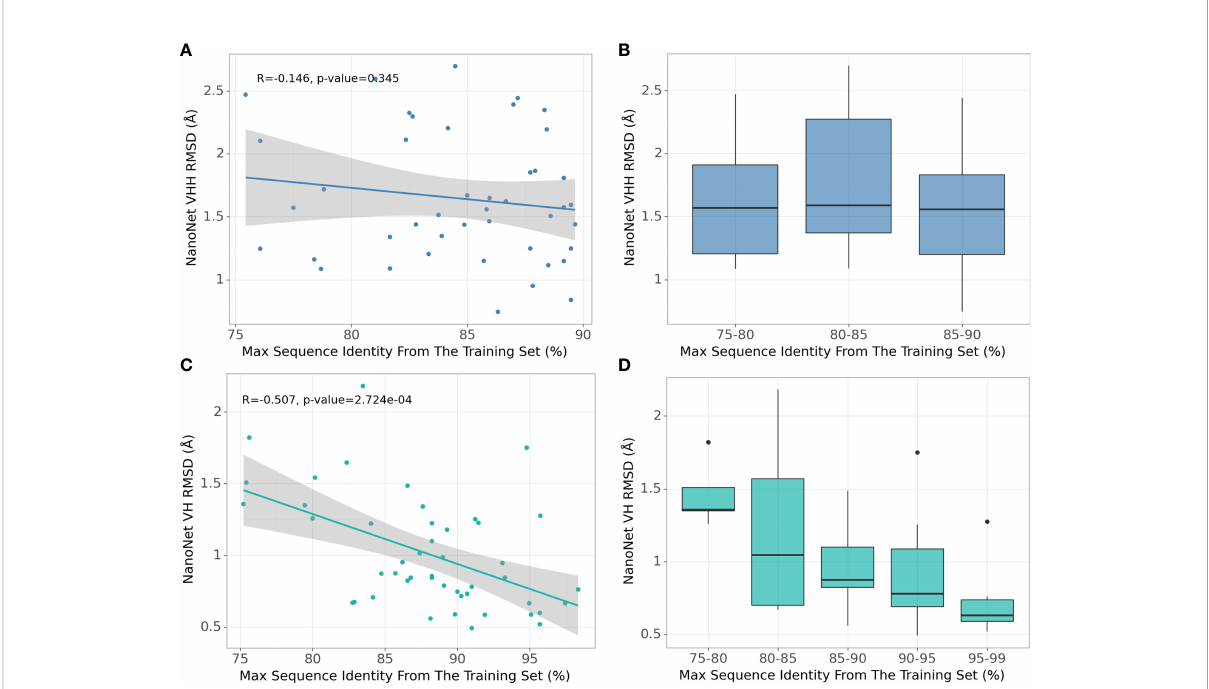
FIGURE 4 Effect of splitting the train and test sets using different sequence identity cutoffs. (A) NanoNet test set performance (measured as VH/VHH RMSD) as a function of maximal sequence identity to the train set, each dot represents a structure from the Nb test set (44 structures), (B) Test set performance with boxplots for sequence identity ranges for the Nb test set (44 structures), (C) same as (A) but for the mAb test set (47 structures), (D) same as (B) but for the mAb test set (47